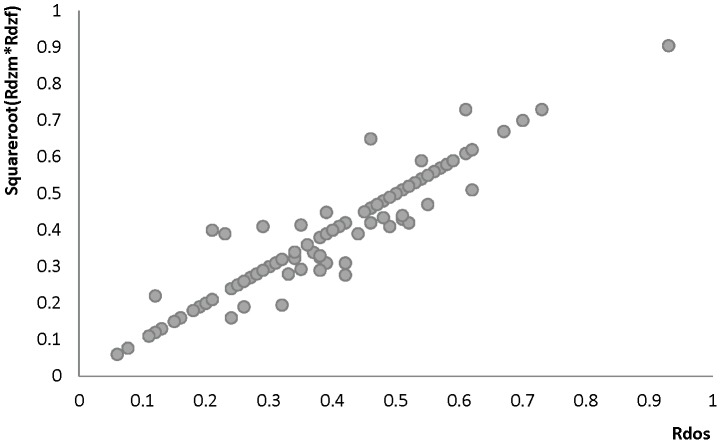
Summary of all observed correlations in opposite-sex twin (x-axis)pairs versus expected correlations correlations based on same-sex dizygotic twin correlations pairs(y-axis) for all 122 phenotypes included in the present paper.